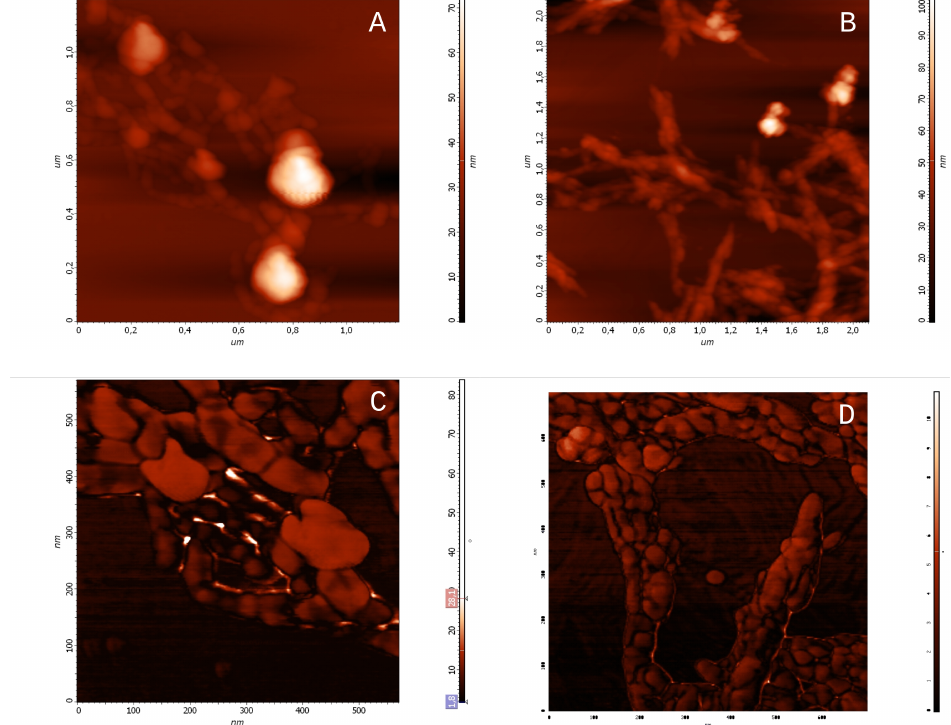
Figure A2. AFM images of the MCC obtained in a single ( A , C ) and double ( B , D ) cycles of acid hydrolysis and